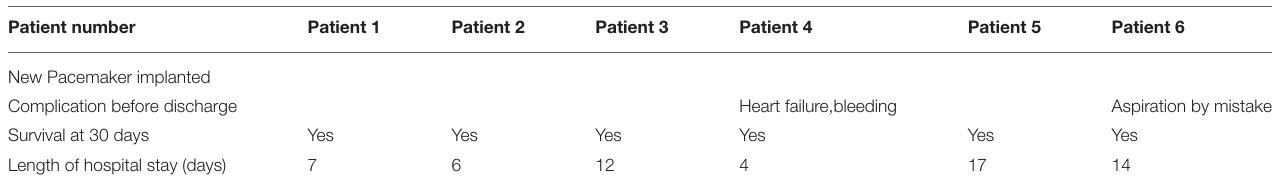
TABLE 5 | Follow-up of patients undergoing transcatheter mitral valve implantation. Patient